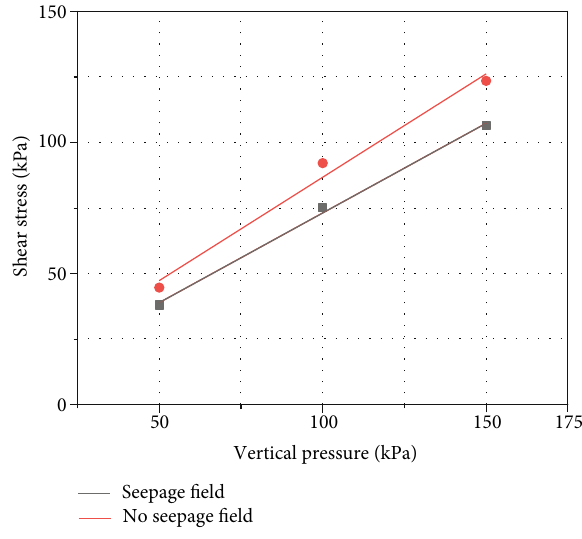
Figure 6: Shear experiment